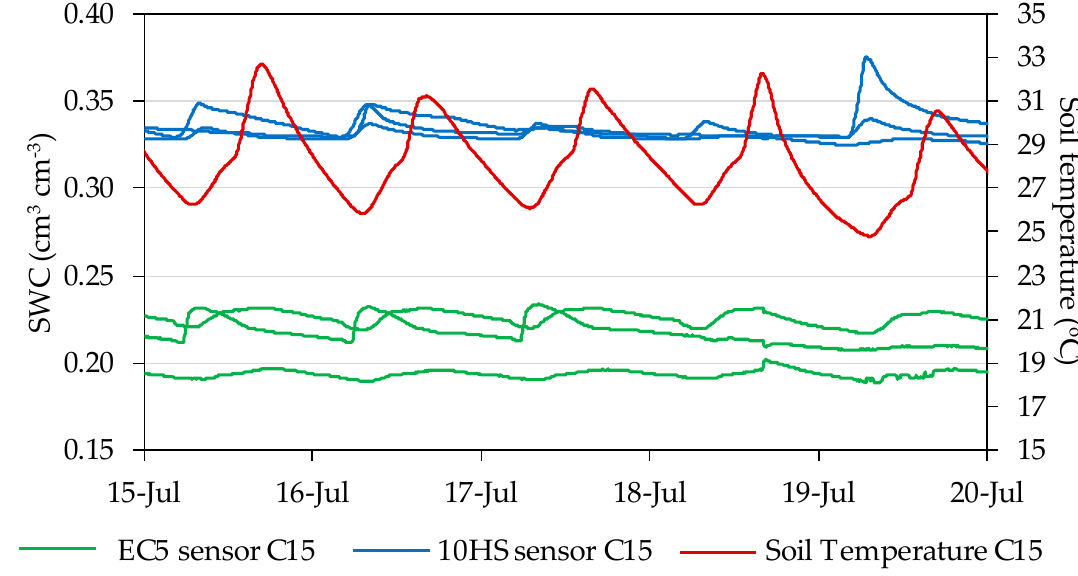
Figure 6. Comparison of daily fluctuations in soil temperature and SWC at position C, 15 cm depth in Plot I in July 2015.